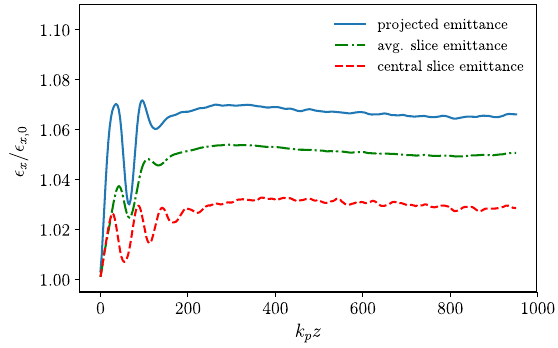
5. Emittance evolution of the positron witness beam. Shown are the projected emittance (blue curve), the beam- averaged slice emittance (green curve) and the slice emittance of the central slice (red curve),